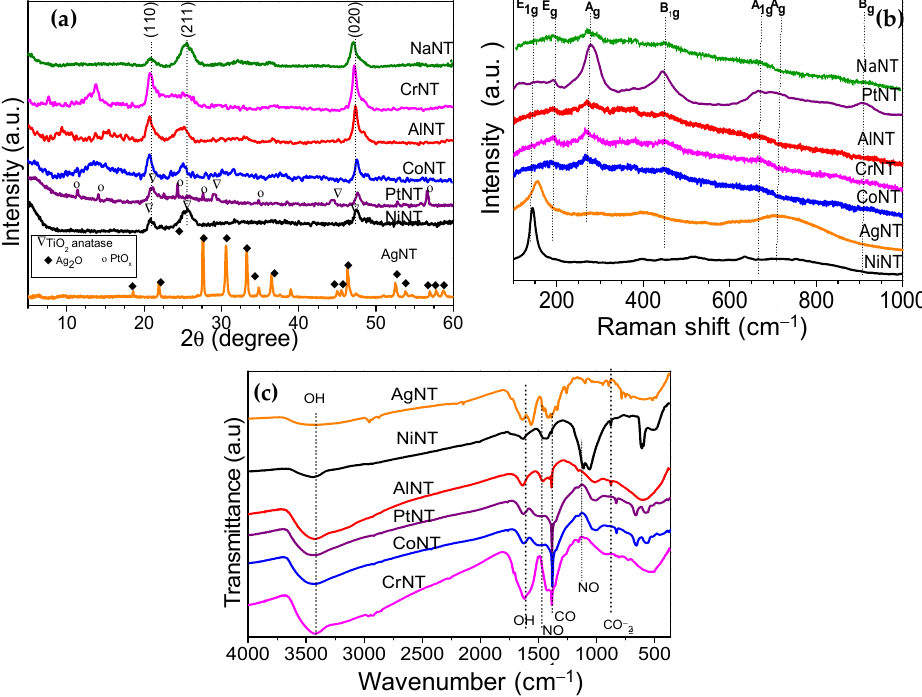
Figure 8. Spent characterizations of the titanate nanotubes catalysts: ( a ) XRD patterns, ( b ) Raman and ( c ) FTIR spectra. Reaction conditions: amount of the catalyst, 0.15 g; reaction gas mixture, 500 ppm of NO, 1000 ppm of CO and balance in He; flow rate, 80 mL min − 1 ; space velocity, 48,000 h − 1 at 250 °C for 600 min.